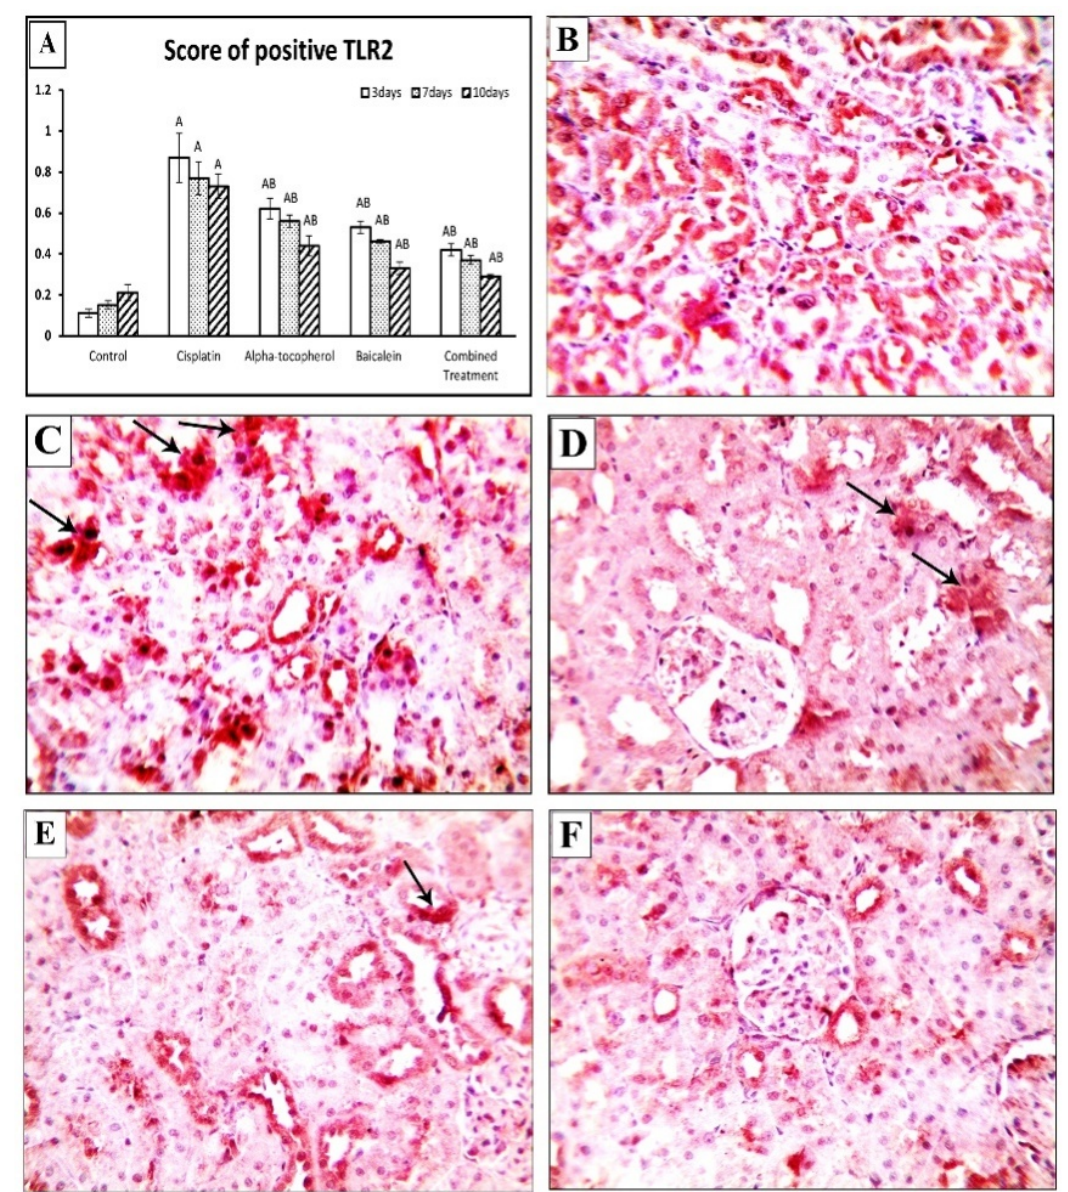
Figure 9. Microscopic pictures of adrenal sections immunostained against TLR2 from rat groups sacrificed after 10 days showing ( A ) positive cell score, significant vs. control group refers to A, while significant vs. (cisplatin, -tocopherol, and baicalein) treatment groups refers to (B, C, D), respectively, ( B ) control group, and ( C ) marked expression in positive brown tubular expression in Cisplatin group. ( D ) The positive brown tubular expression slightly decreased in renal sections from α -tocopherol group, ( E ) moderately decreased in renal sections from baicalein group, and ( F ) significantly decreased in renal sections from the combined treatment group. Black arrows indicate positive reaction. IHC counterstained with Mayer’s hematoxylin. High magnification ×: 400 bar 50.